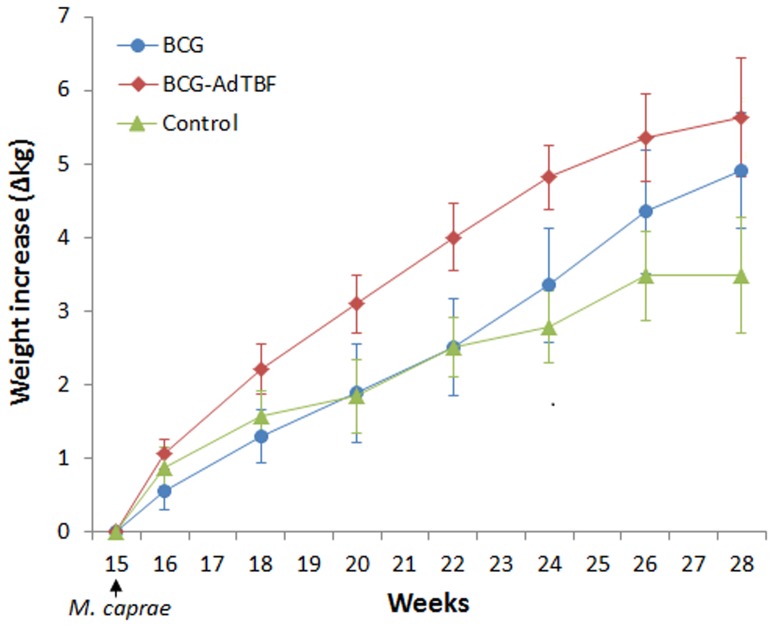
Body weight after M. caprae infection.Goats were challenged with 1500 CFU M. caprae at week 15 and weighted weekly untill the end of the experiment (week 28). Each line represents the cumulative weight increases (in kg ± 95% CI) in the three treatment groups from the challenge to the end point.